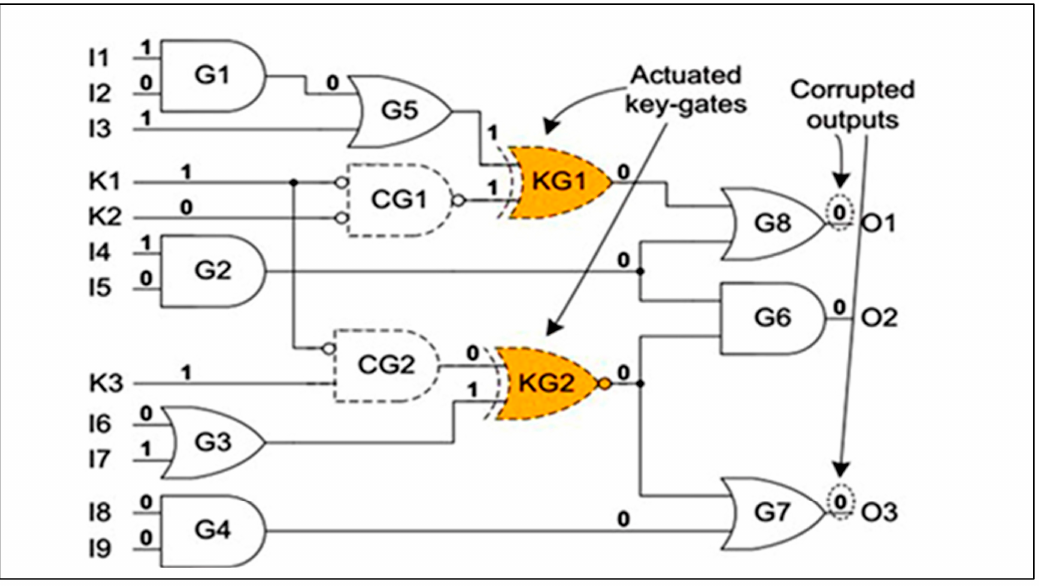
Figure 8. Key gate actuation with weighted logic locking [11]